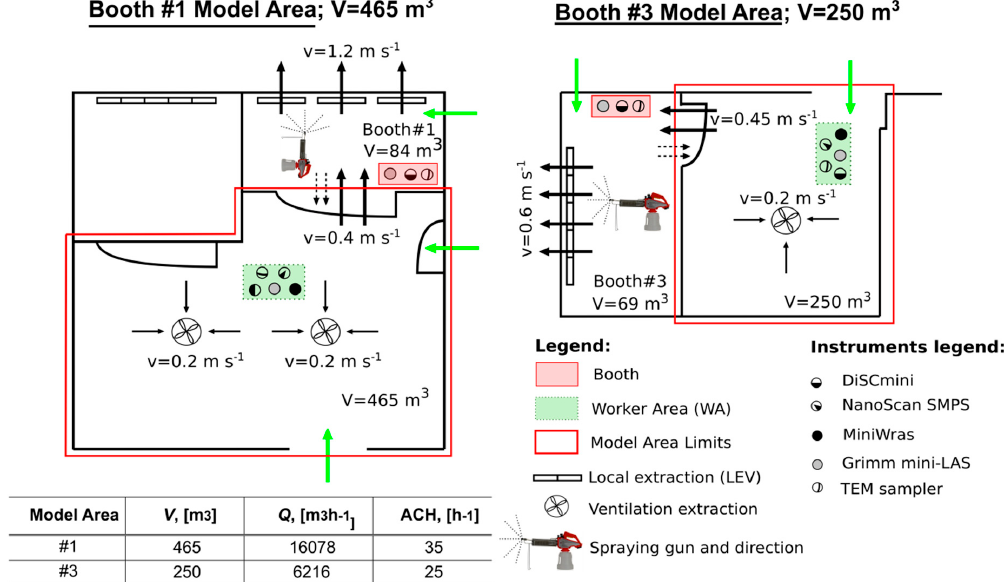
Figure 1. Modeled areas limit, volumes (m 3 ), ventilation air speeds (m s –1 ), and description of instruments deployed and their location. Green and black arrows indicate incoming air flows and ventilation extraction flows, respectively. Dashed arrow indicates air flow from booth to WA. The table shows parameterization of the one-box model: V (m 3 ) is volume used for modeling, Q (m 3 h –1 ) is ventilation air volume flow through the WA, ACH (h –1 ) is the air changes per hour calculated from measured air speeds and used for modeling.